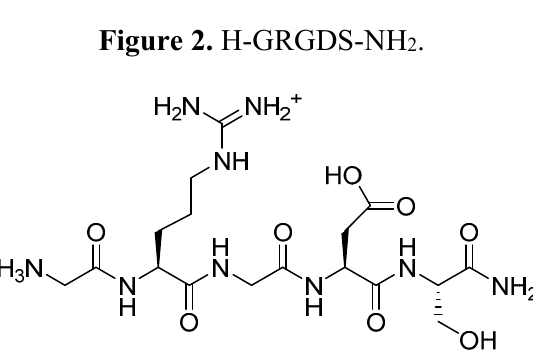
Figure 2. H-GRGDS-NH 2